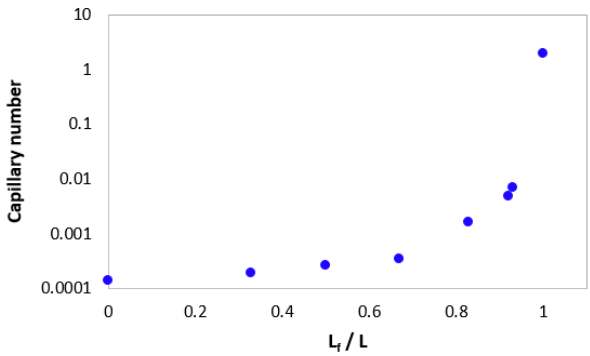
Figure 8. The capillary number with different fracture lengths in Type I.